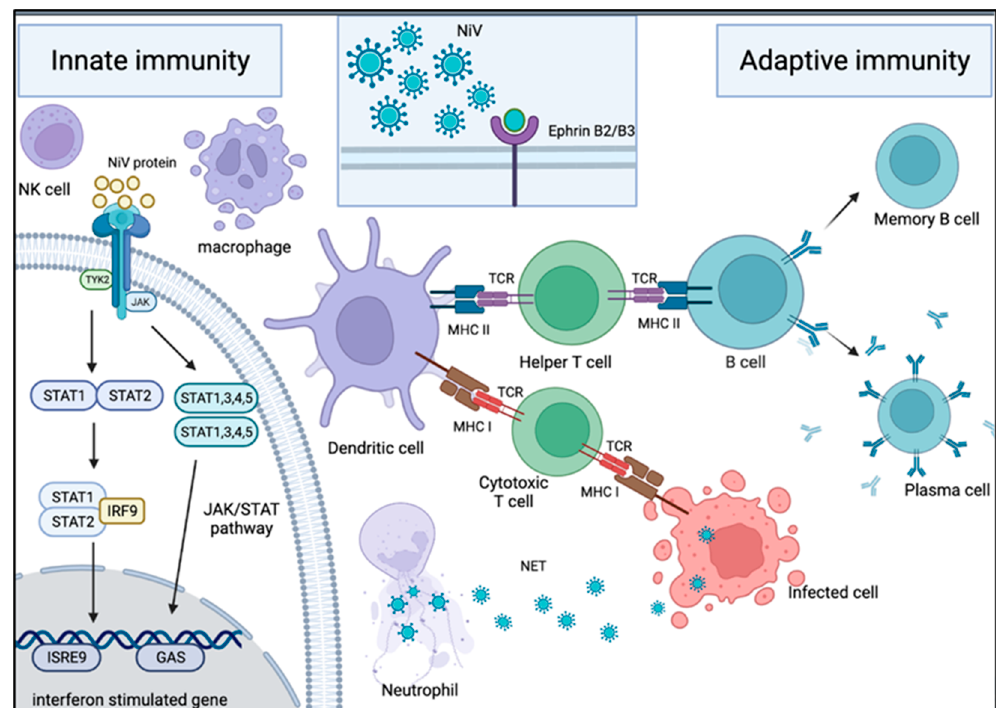
Figure 3. Mechanism of host immune response in NiV infection. Innate immune response upon NiV infection: Neutrophils are one of the first immune cells to be recruited to the site of infection. These cells use NET and antiviral molecules to contain the virus in web-like traps. To counteract this, some NiV proteins are capable of inhibiting the IFN response by interacting with the JAK/STAT pathway. Adaptive immune response upon NiV infection: Following NiV entry via ephrin-B2 or -B3 receptors on the host cellular membrane, it is engulfed and broken down into viral peptides by APC such as macrophages and dendritic cells. The presentation of the viral peptides on the MHC molecules activates the T cells through their TCR. The activation of the helper T cells subsequently drives B cells to activate, proliferate and develop a mature antibody response. As a result, plasma cells and memory B cells are formed, producing NiV-specific antibodies for protection against infection. On the other hand, the activation of cytotoxic T cells allows them to target and kill the NiV-infected cells.